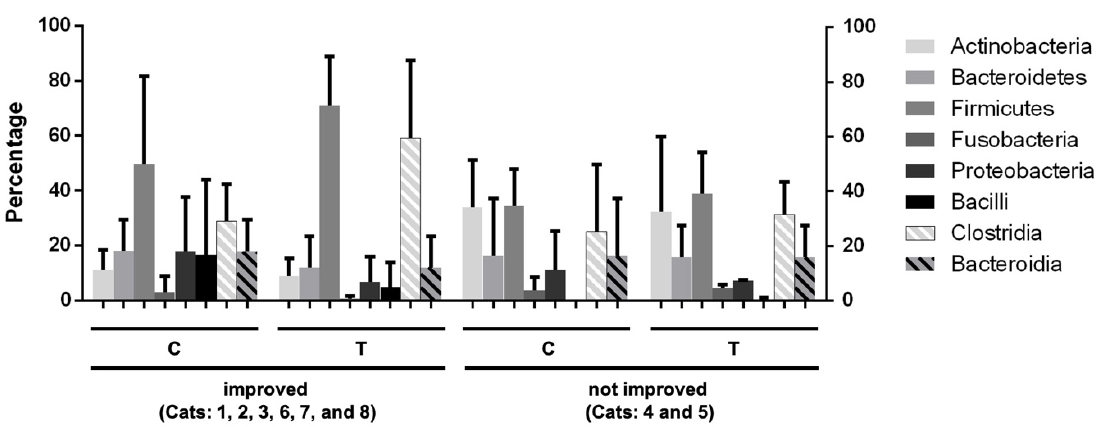
Figure 5. Changes in the percentage of selected bacterial phylum and class components in diarrheal cats having clinical improvement (cats: 1, 2, 3, 6, 7, and 8) before and after Bacillus licheniformis - fermented products (BLFP) treatment and diarrheal cats (cats: 4 and 5) without clinical improvement. C: before the BLFP treatment; T: after the BLFP treatment. Table 2. The significant ( p < 0.05) changes in OTU-based microbiome in diarrheal cats before and after the treatment with Bacillus licheniformis -fermented products (BLFP).